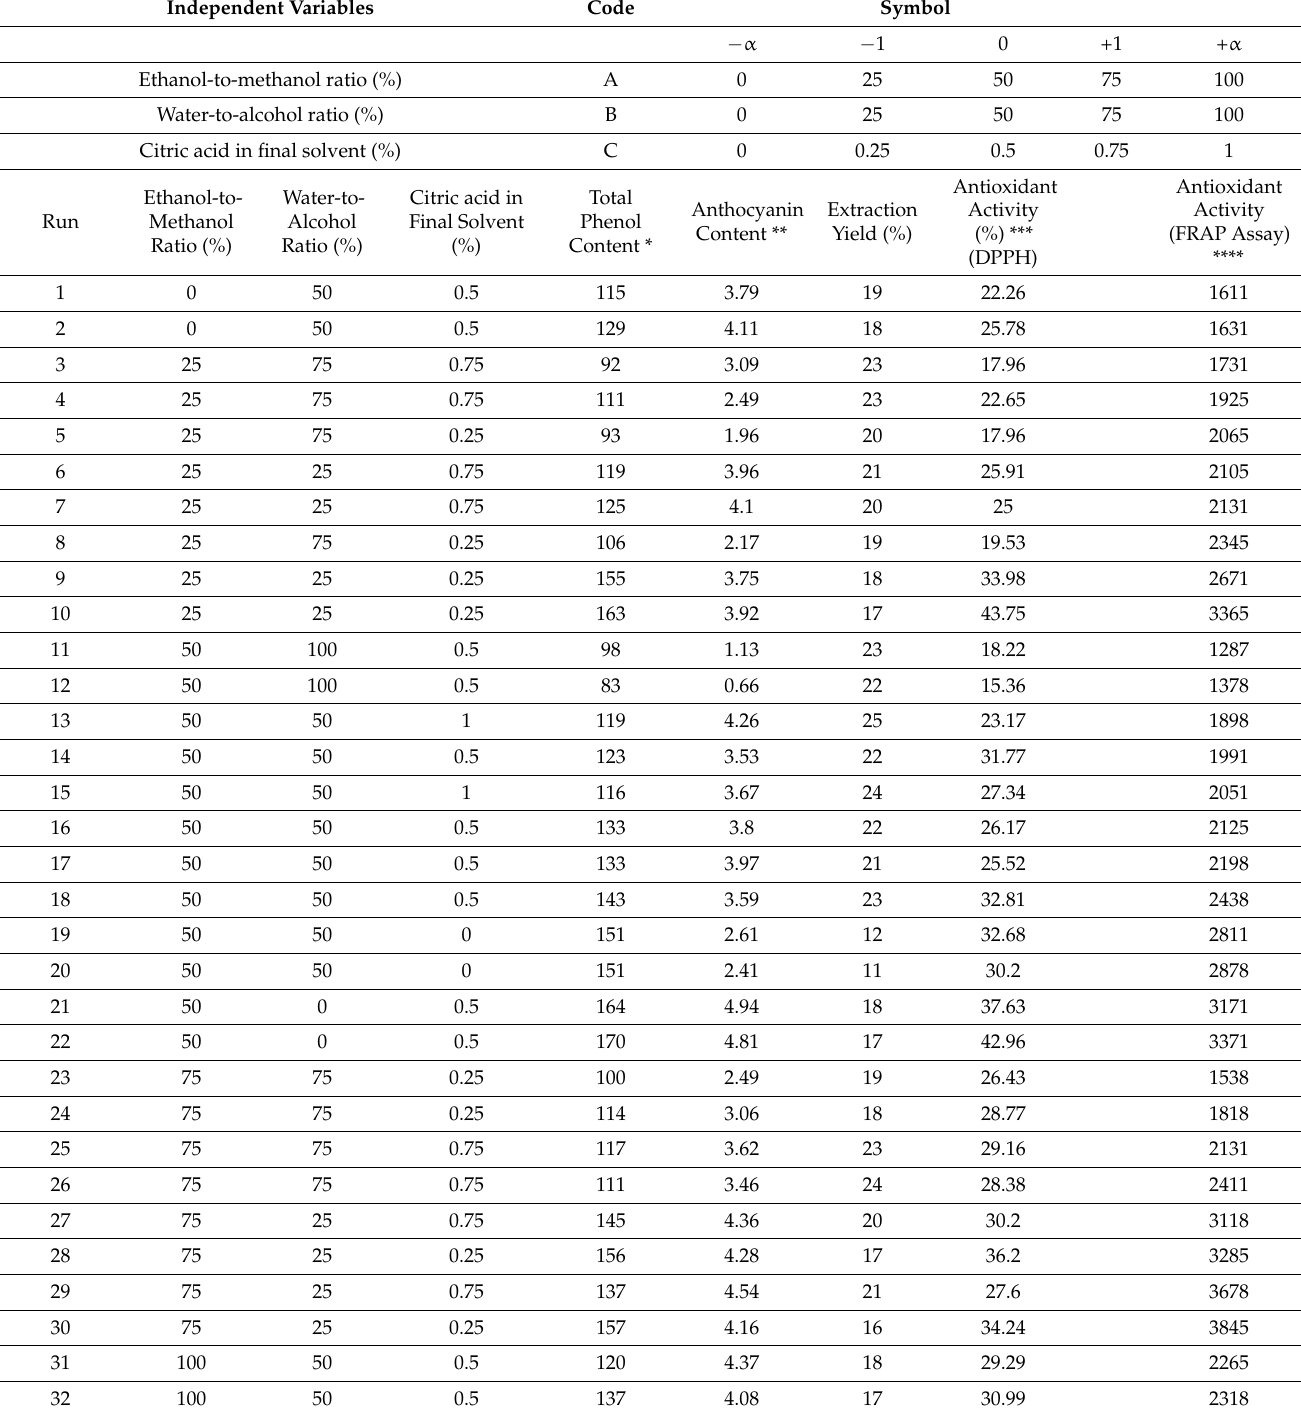
Table 1. The uncoded and coded level of the independent variables and the composite central design (CCD) matrix, and the experimental data for the RSM responses in bioactive compound extraction of eggplant peel by the different solvent